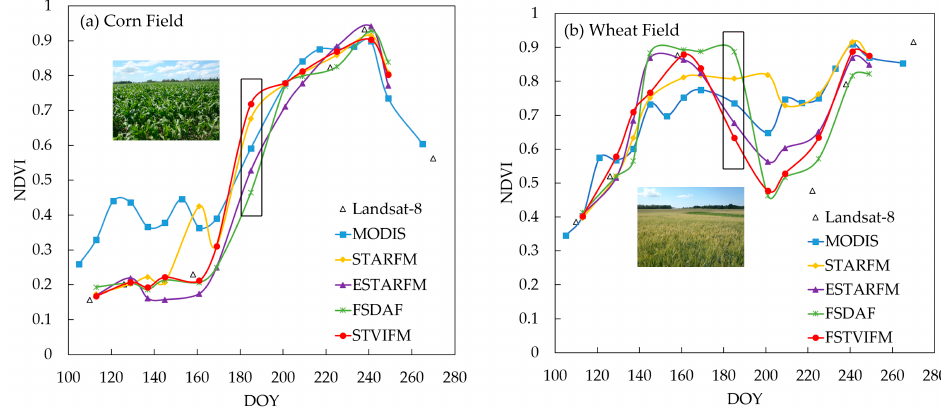
Figure 16. Time series of the average NDVI of: the cornfield ( a ); and the wheat field ( b ), generated by the STARFM, ESTARFM, FSDAF, and STVIFM algorithms. The predictions shown in the black box (DOY 185) present large difference between the FSDAF and STVIFM. The pictures were collected two days before that date (DOY 183).